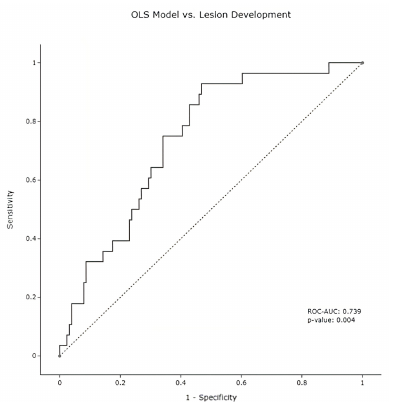
Figure 2. OLS ROC Curve. Receiver operating characteristic (ROC) curve in patients ( n = 22) for the prediction of pancreas cancer development using the following baseline SSF2 radiomic features (mean, skewness, kurtosis mean split, and total pancreas fat %). This model was statistically significant with an Area Under the Curve (AUC) = 0.7392, p -value = 0.004.